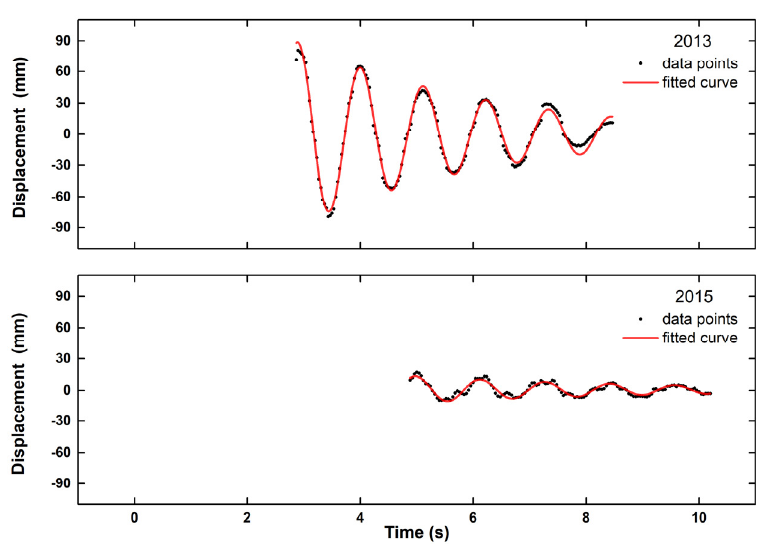
Figure 6. Modeling of the free attenuation intervals of the oscillations of point P2 as free attenuating oscillations based on Equation (9). The period input into the analysis was computed from the spectra of Figure 5. Table 3. Variations of the first lateral natural frequency f of the Kanellopoulos Bridge, known from the analysis of geodetic sensors and accelerometers (from Thalla and Stiros [11], with additions) and those derived in this study.